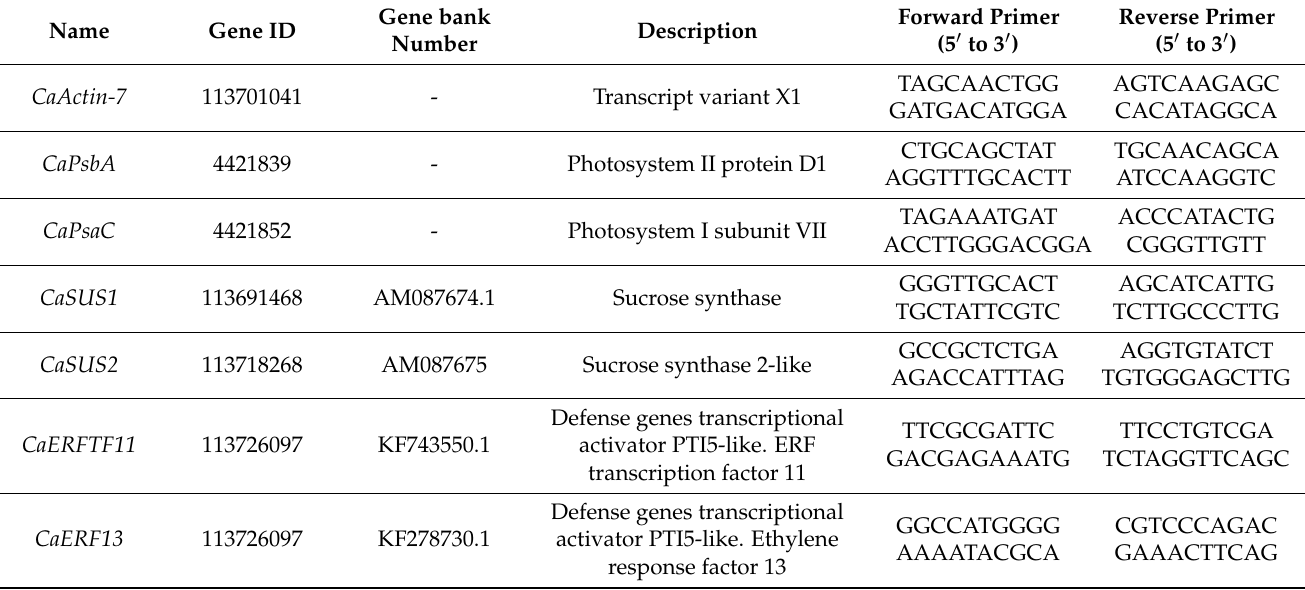
Table 4. List of the primers used to quantify expression levels of